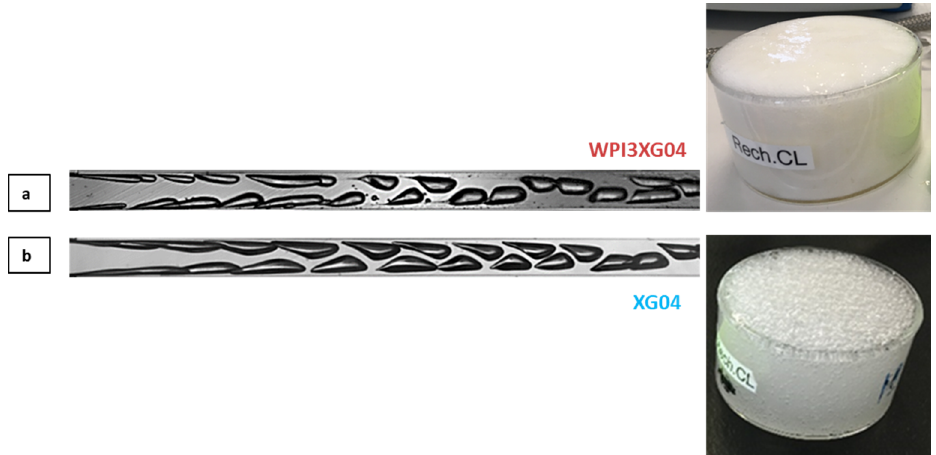
Figure 12. Visualizations of bubbles in the outlet microchannel and visual aspect of foams ob- tained at the end of the process when using the device CX600 and flowrates Q vL = 11 L · h − 1 and Q mG = 21.6 g · h − 1 . ( a ) Solution WPI3XG04. ( b ) Solution XG04. The crystallizing dishes have an approximative diameter of 8 cm and a height of about 5